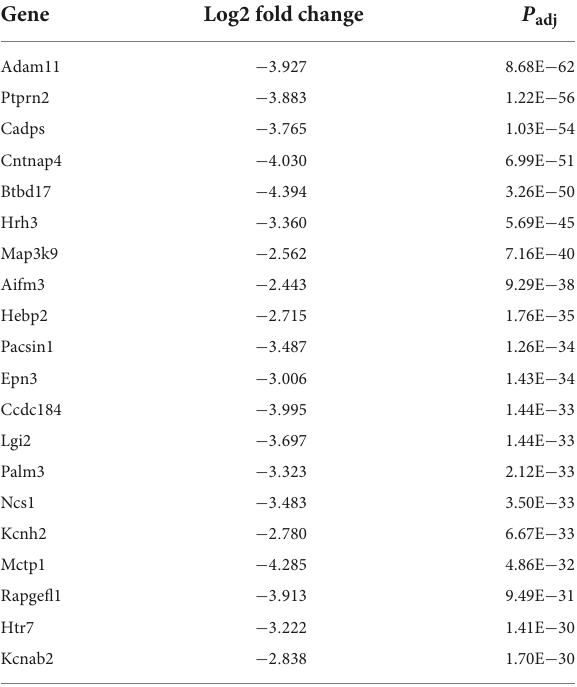
TABLE 5 The top twenty downgraded differentially expressed metabolites